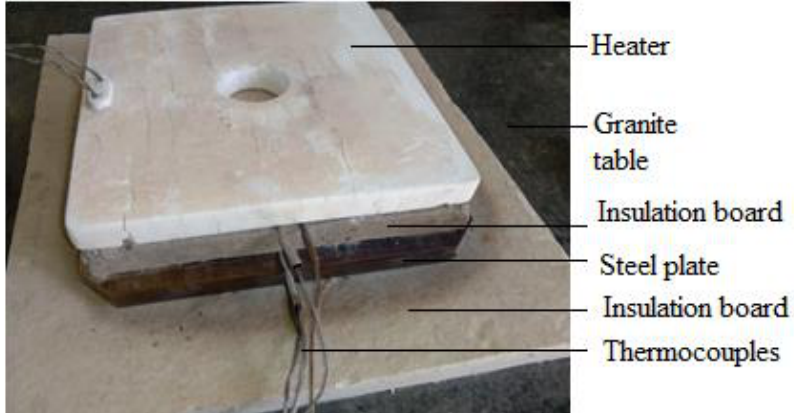
Figure 4. Validation model